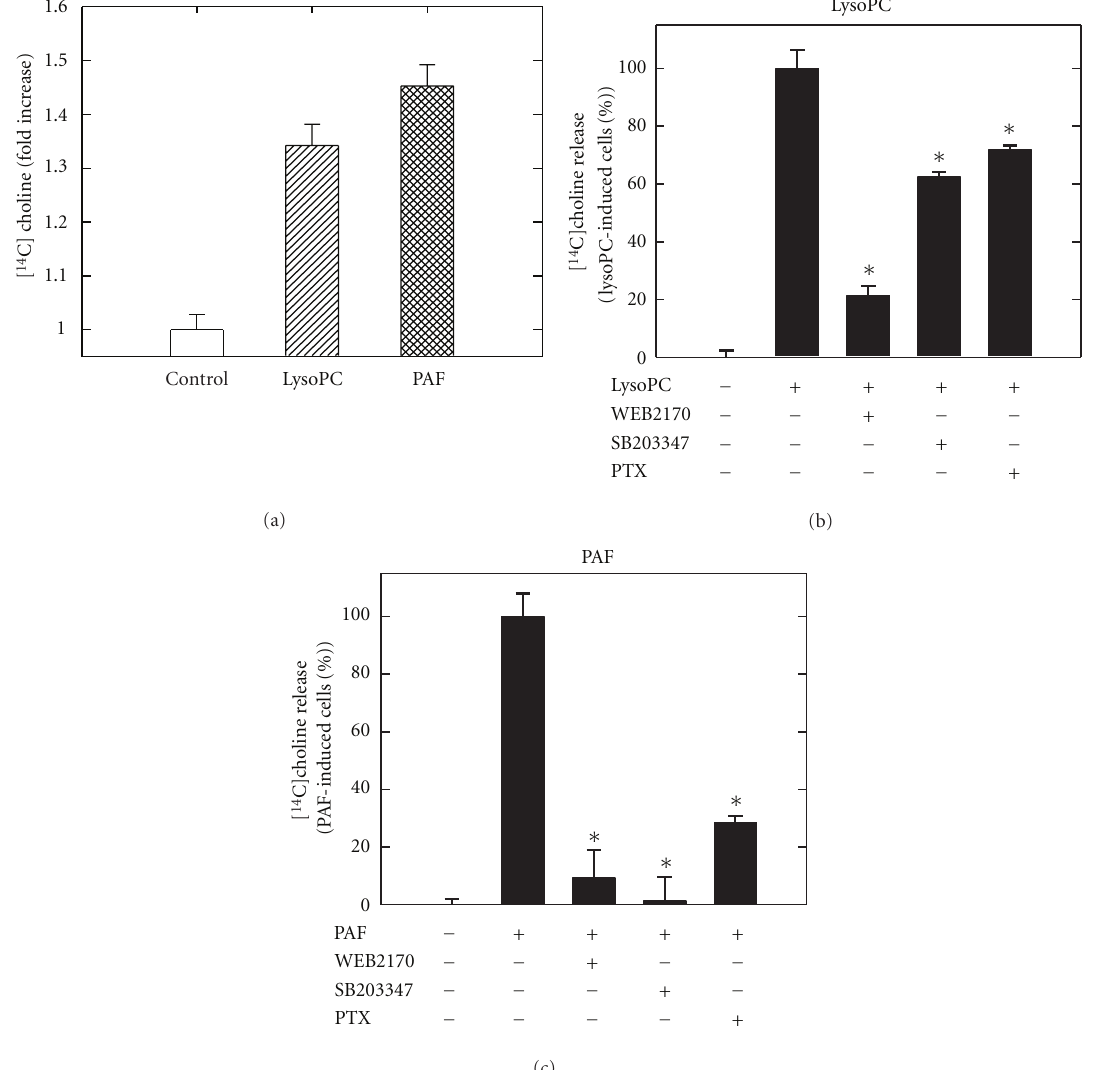
Figure 4: LysoPC and PAF stimulate PLD activity. (a) [ 14 C]choline prelabeled THP-1 cells were stimulated with lysoPC or PAF for two minutes, and [ 14 C]choline released in the medium was measured after TLC separation. (b) and (c) [ 14 C]choline prelabeled THP-1 cells were preincubated with WEB2170, SB203347, or PTX before (b) lysoPC or (c) PAF challenge. Data are expressed as means ± SD of triplicate determinations within separate experiments. Asterisks indicate that values are statistically di ff erent from PAF- or lysoPC-treated cells ( ∗